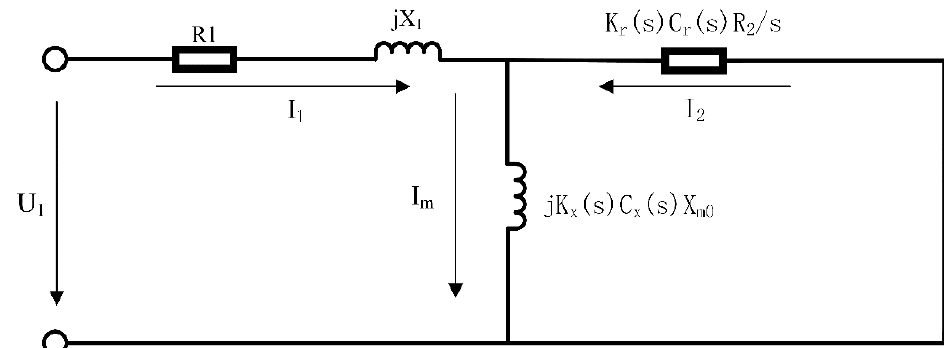
Figure 3. Equivalent circuit of the SP-DLIM.